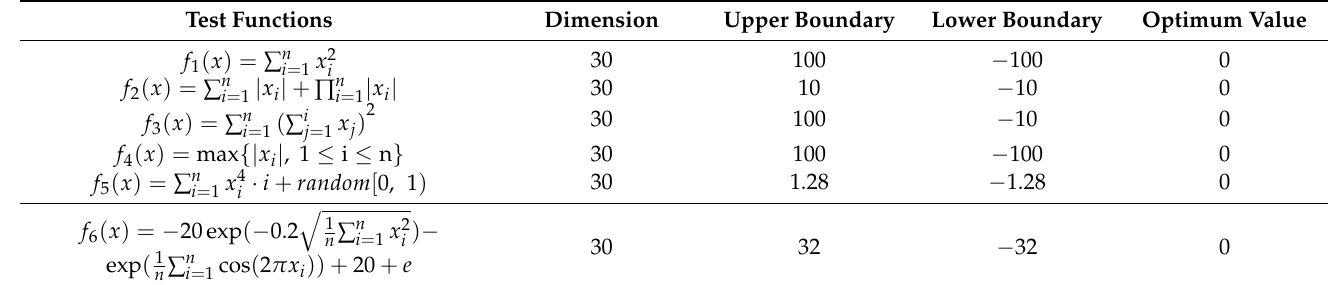
Table 1. Test Functions.